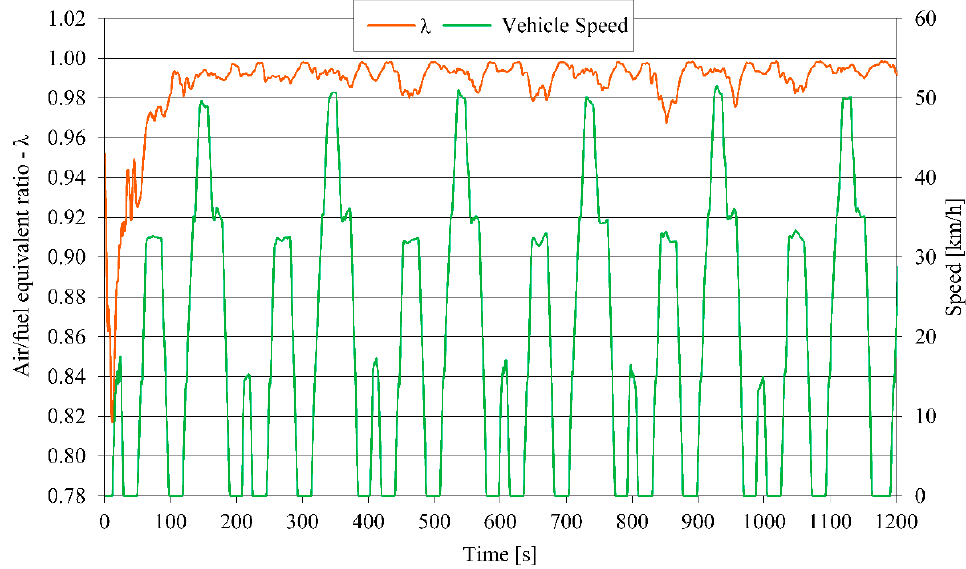
Figure 4. Air/fuel equivalence ratio λ and speed–time profile measured during the UDC driving cycle. ing